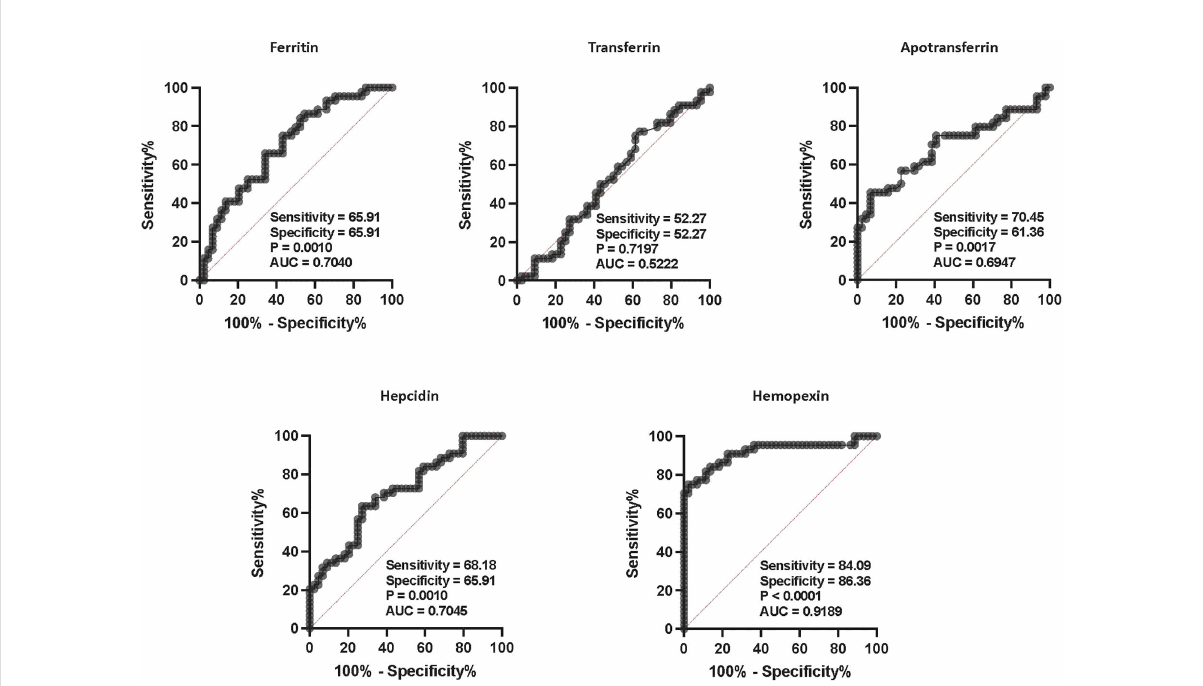
FIGURE 4 ROC analysis of iron status biomarkers. ROC analysis of iron status (ferritin, TF, ApoT, hepcidin, hemopexin) biomarkers in TBL+ (Ss+, n=44 and Ss-, n=44) groups was performed to evaluate the sensitivity, speci fi city, and area under the